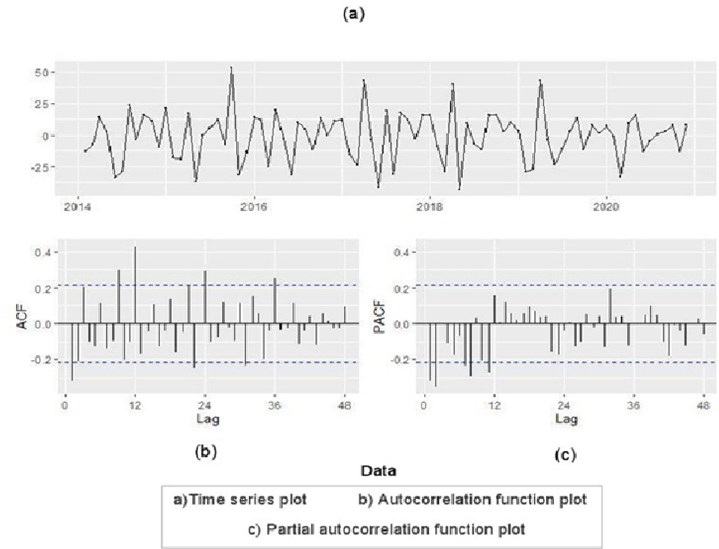
Fig 3. Autocorrelation, partial autocorrelation function and time series plots of leishmaniasis in Kerman, Iran during 2014–2020 after one time differentiation. The x axis represents the lag at which the autocorrelation is computed; the y axis indicates the value of the autocorrelation.